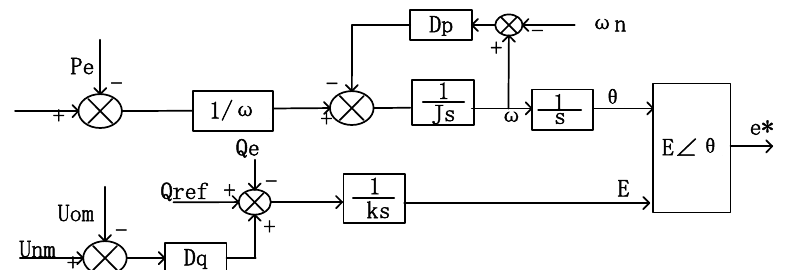
Figure 4. Block diagram of VSG